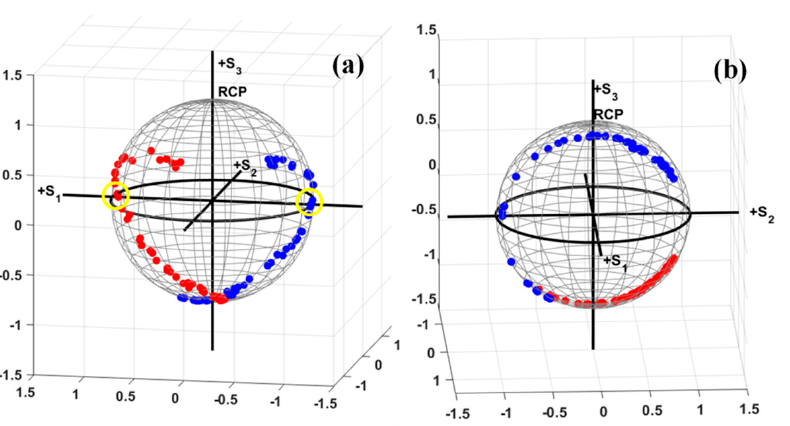
Figure 6. Poincare sphere representation of SOP modulation characteristics of the SLM ( a ) for − 45° polarized (red plot) and for − 45° polarized (blue plot) input light, and ( b ) for x-polarized polarized (red plot) and y-polarized (blue plot) input light. Circles in yellow represent the SOP at grayscale 180.